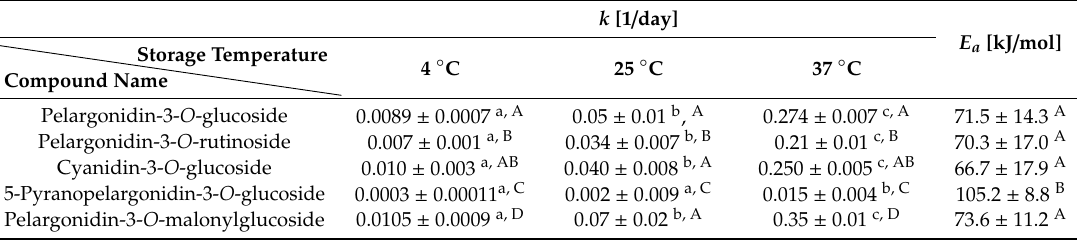
Table 2. First order degradation rates ( k [1 / day]) obtained during shelf-life experiment for the identified anthocyanins in the strawberry extract stored at 4 ◦ C, 25 ◦ C and 37 ◦ C and their activation energies ( E a [KJ / mol]) (citric bu ff er pH = 3, 50 mM).